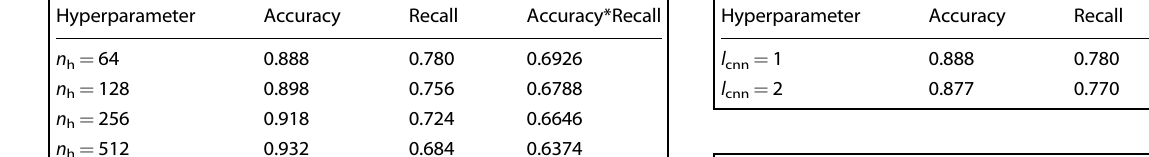
Table 5. Validation results for dropout rates.